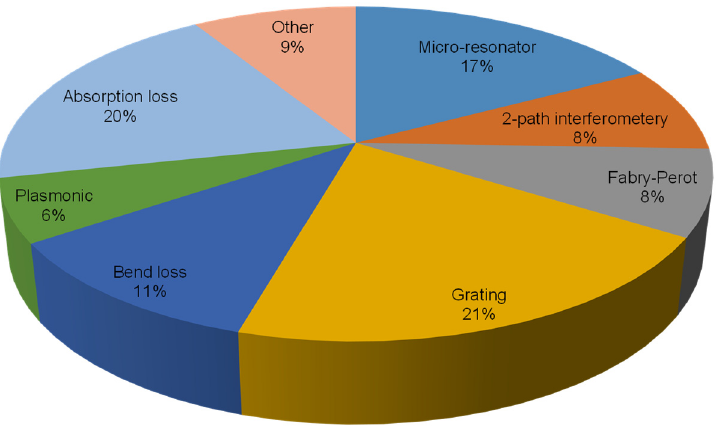
Figure 1. Types of sensing mechanisms for point humidity sensors and their usage percentage.